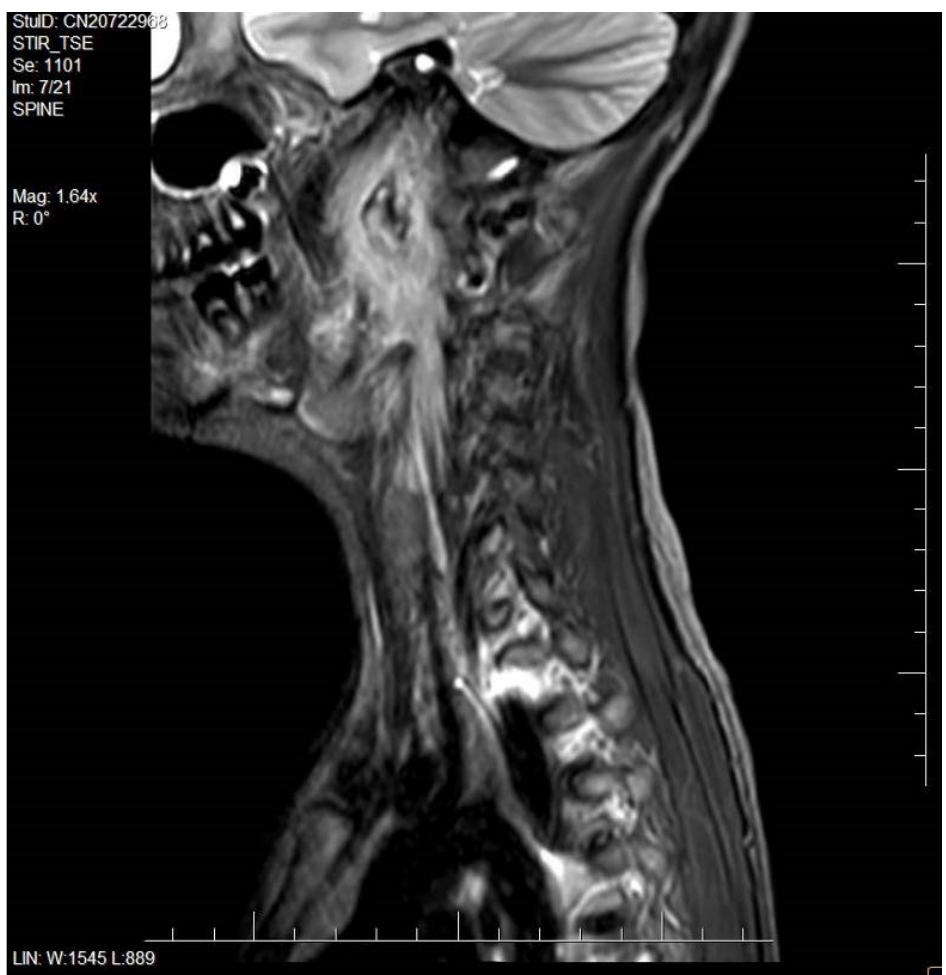
Figure 2. Magnetic resonance of head-saggital plane.